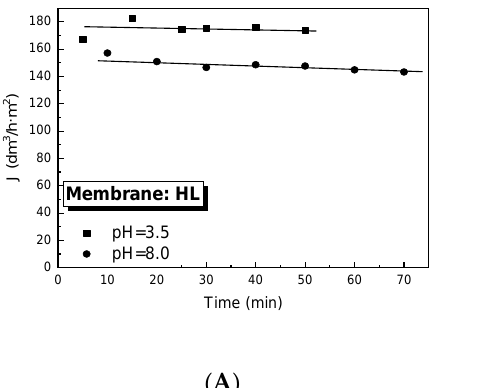
Figure 5. ( A ) Dependence of retention on the degree of initial bath concentration; ( B ) dependence of concentration of salicylic acid and products of its oxidation in the concentrate on the degree of initial bath concentration; ( C ) dependence of the concentration of salicylic acid and products of its oxidation in the filtrate on the degree of initial bath concentration; TS80 membrane, pressure 1.0 MPa, temperature 30 °C. Abbreviations: SA- salicylic acid; 2,3-DHBA- 2,3-dihydroxybenzoic acid; 2,5-